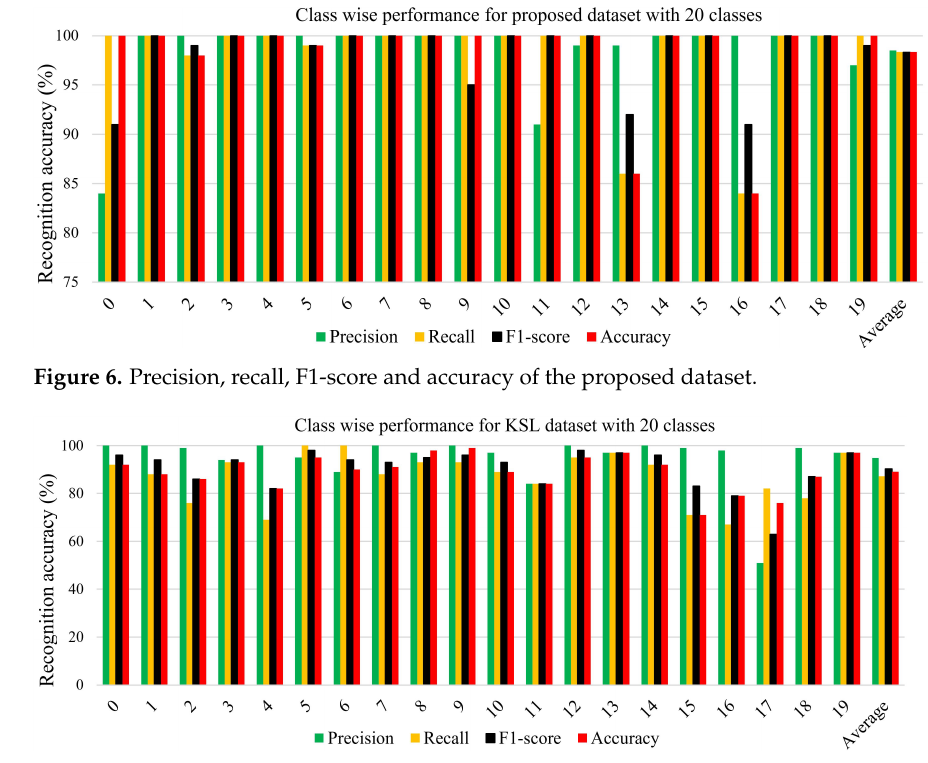
Figure 7. Precision, recall, F1-score and accuracy of the KSL